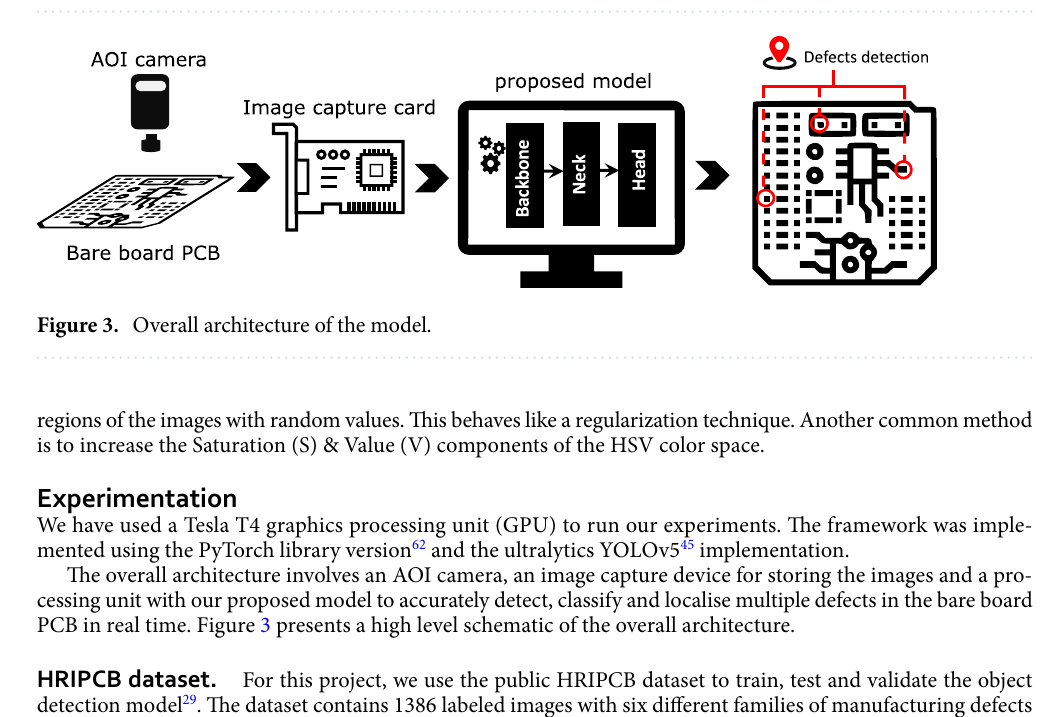
Figure 2. Structure of the proposed model. The structure combines the merits of both transformer and convolutional networks As such, it can exploit global dependencies and locality informations.